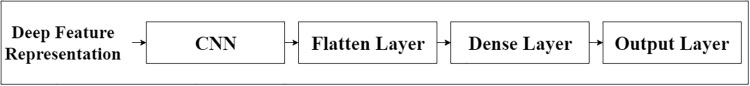
Overview of the deep learning-based classifier.